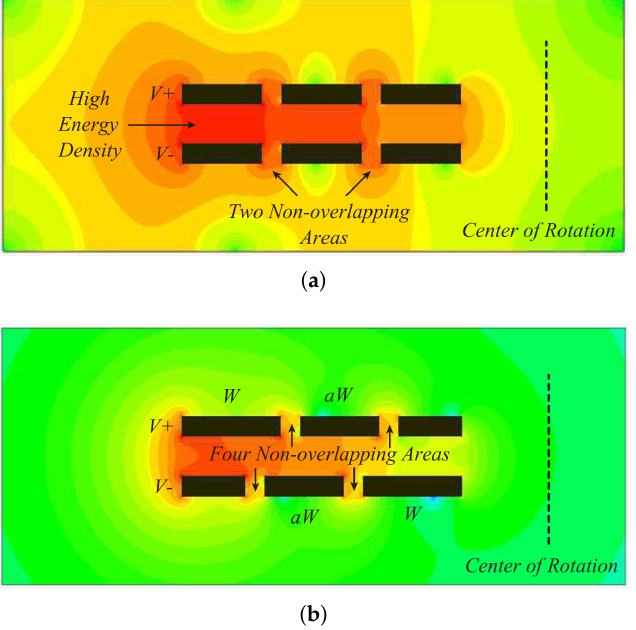
Figure 14. FEA capacitive energy cross-section of ( a ) a traditional planar spiral winding and ( b ) the proposed inverse TWR planar spiral winding. An extremely high capacitive energy area can be found at the input terminals of the traditional winding due to its overlapping conductors. With the proposed winding, much less energy is trapped at the input terminal since the winding provides double the areas without overlap. Reproduced with permission from [56], IEEE,